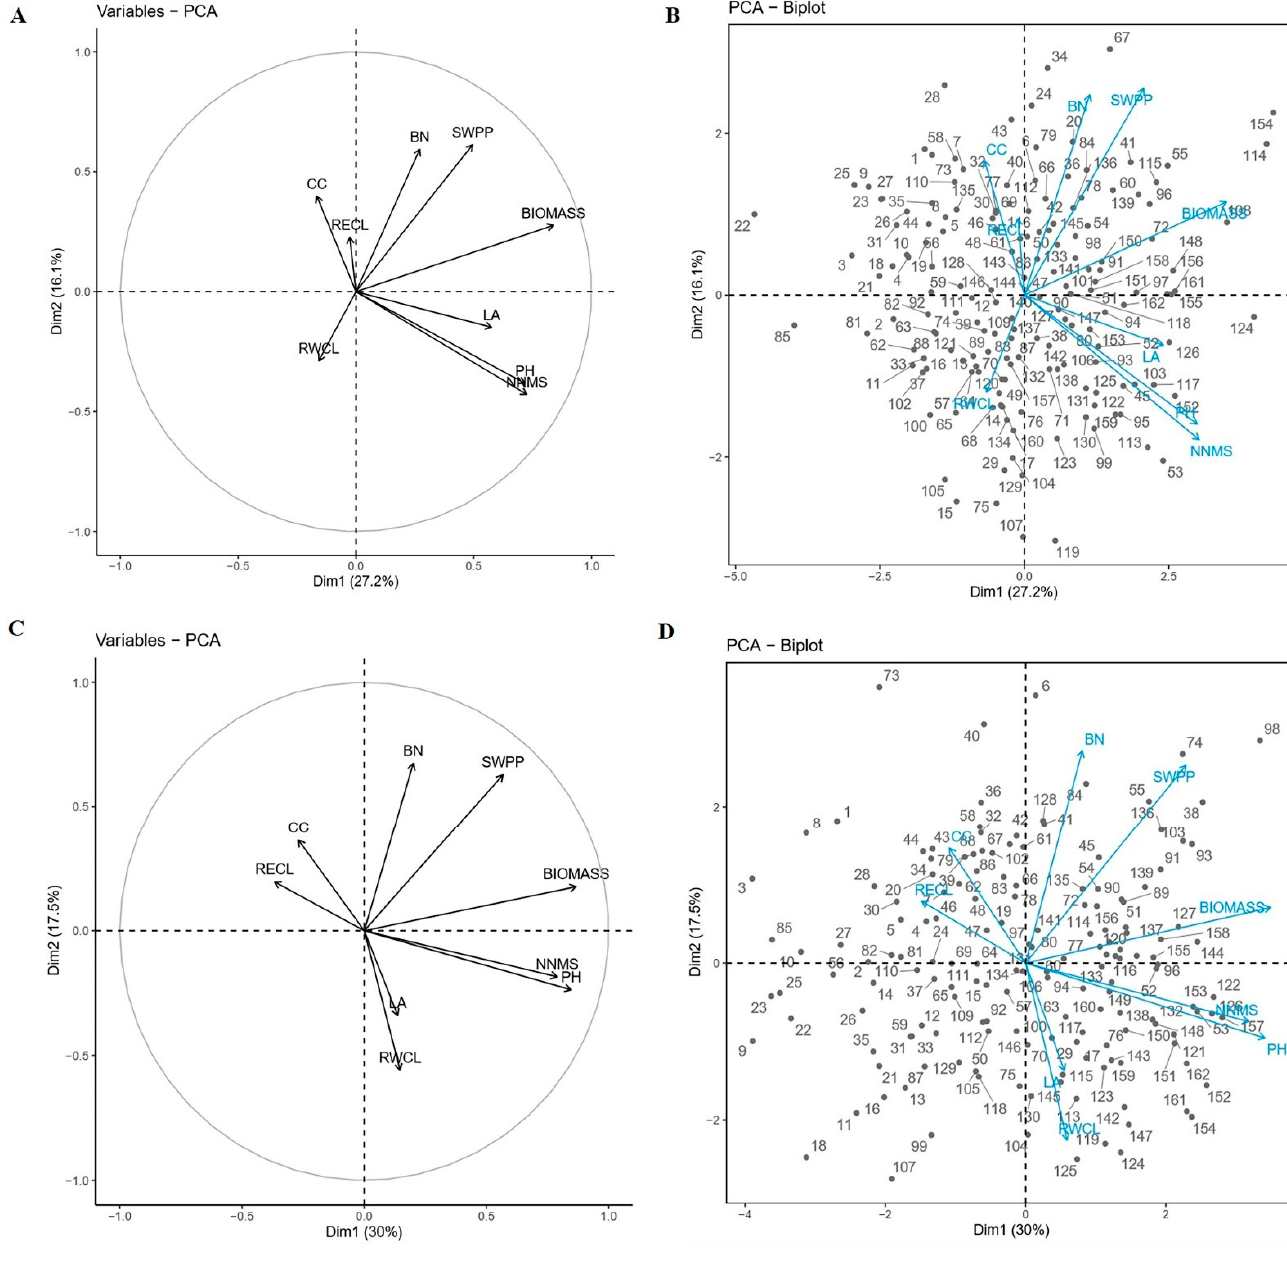
Figure 3. ( A ) The variables factor map of the nine traits under well-watered condition. ( B ) The principal component biplot displaying genotypic grouping under well-watered condition. ( C ) The variables factor map of the nine traits under drought stress condition. ( D ) The principal component biplot displaying genotypic grouping under drought-stress condition. LA, leaf area; PH, plant height; BN, branch number; CC, chlorophyll content; RWCL, relative water content of leaves; RECL, relative electric conductivity of leaves; NNMS, node number of main stem; BIOMASS, biomass; SWPP, seed weight per plant. The diagonal line shows the distribution of nine traits.